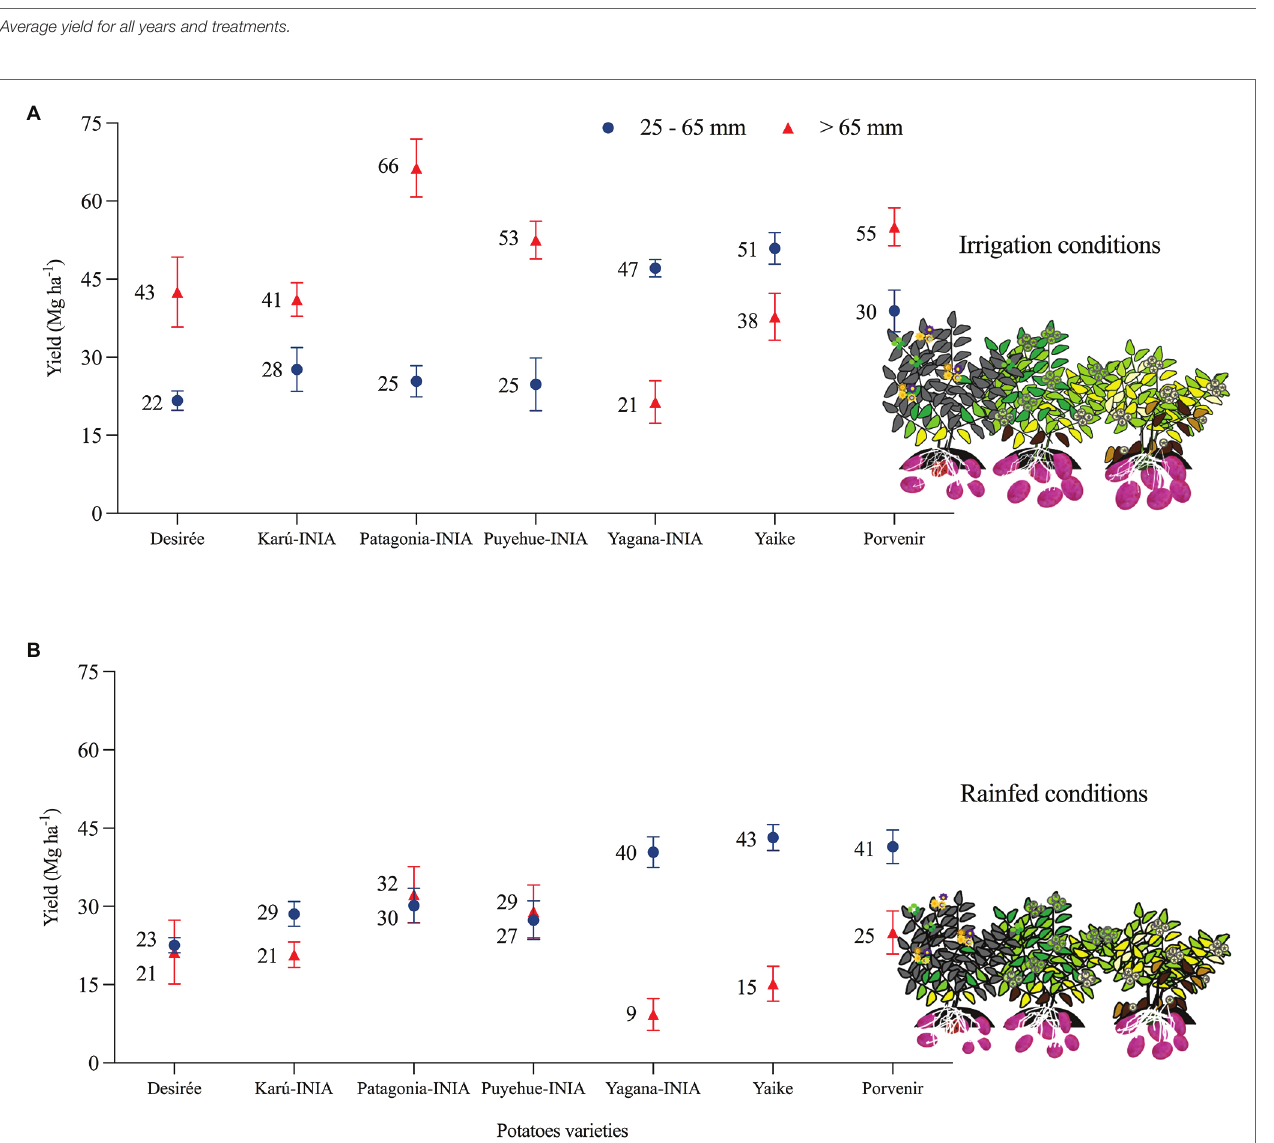
FIGURE 10 | Average tuber size distribution of seven potato varieties under irrigation and rainfed conditions from 2012–14 to 2019–20. (A) Yield of marketable tubers: > 65 mm. (B) Yield of seed tubers (25–65 mm). Error bars indicate SE ( p <